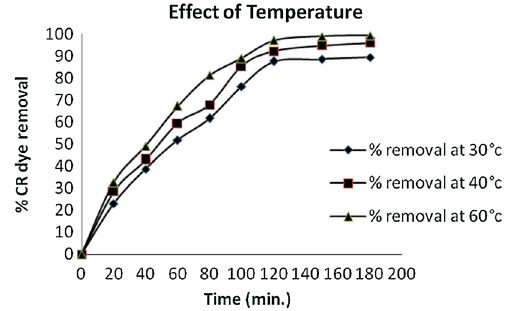
Fig. 13 Effect of temperature on CR dye removal. *Dye